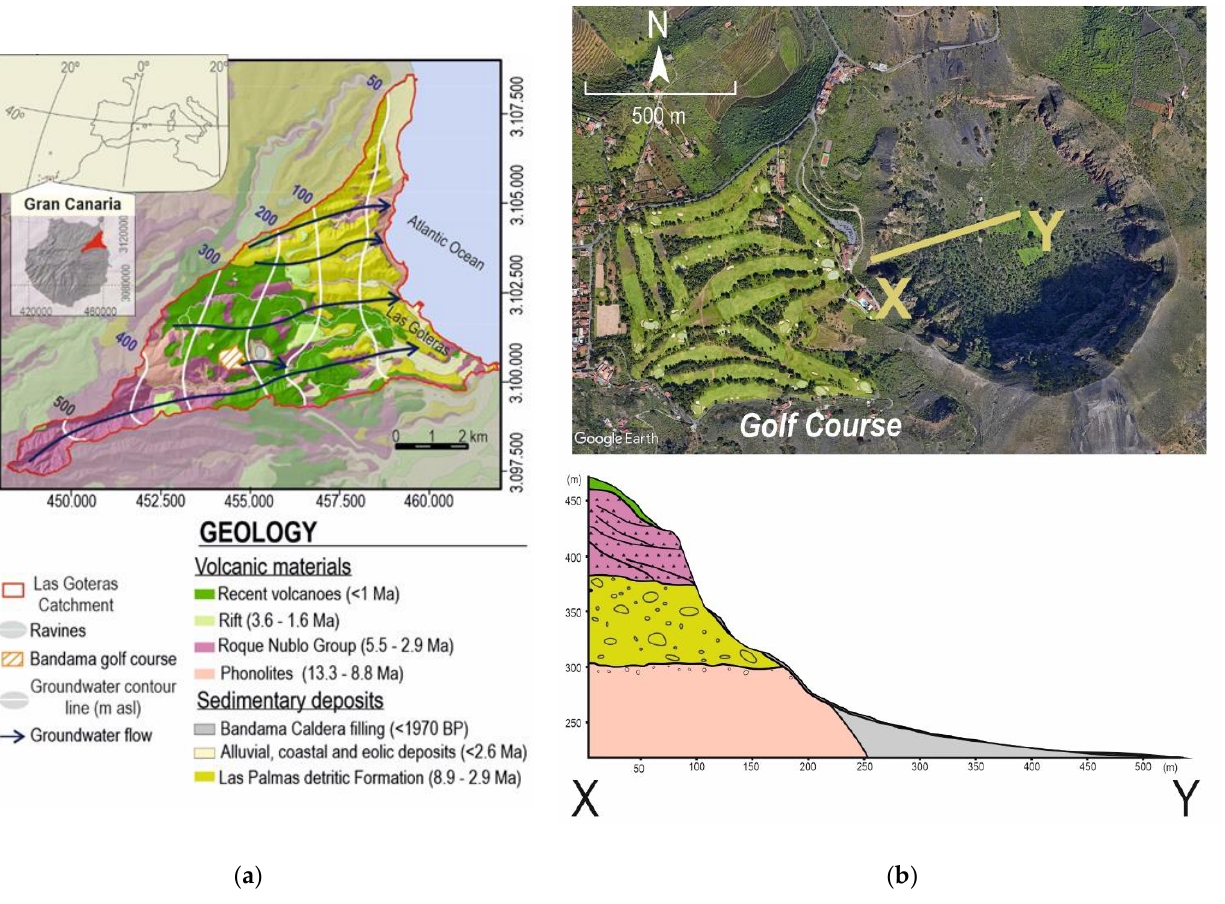
Figure 1. ( a ) Location of the Bandama Golf Course and geology of the Las goteras Basin where simplified piezometry for 2008 data is indicated [24]; ( b ) Geological cross-section from the golf course (X) to the bottom of Bandama Caldera (Y).